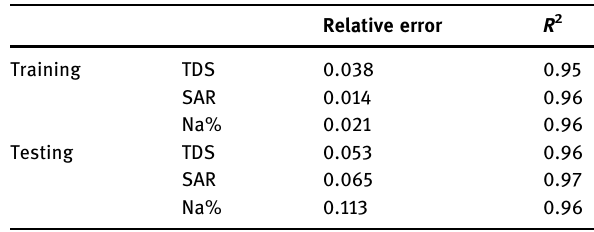
Table 2: The network information for proposed ANN